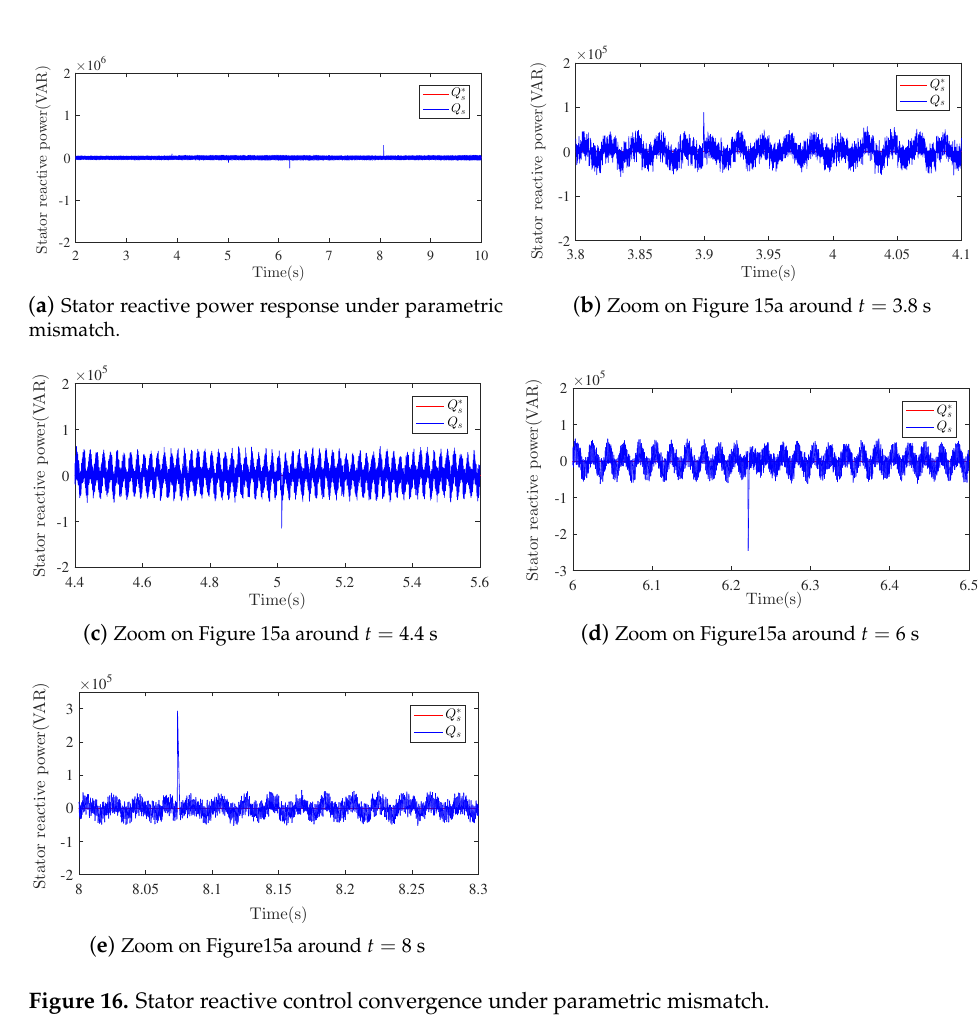
( e ) Zoom on Figure15a around t = 8 s Figure 16. Stator reactive control convergence under parametric mismatch.